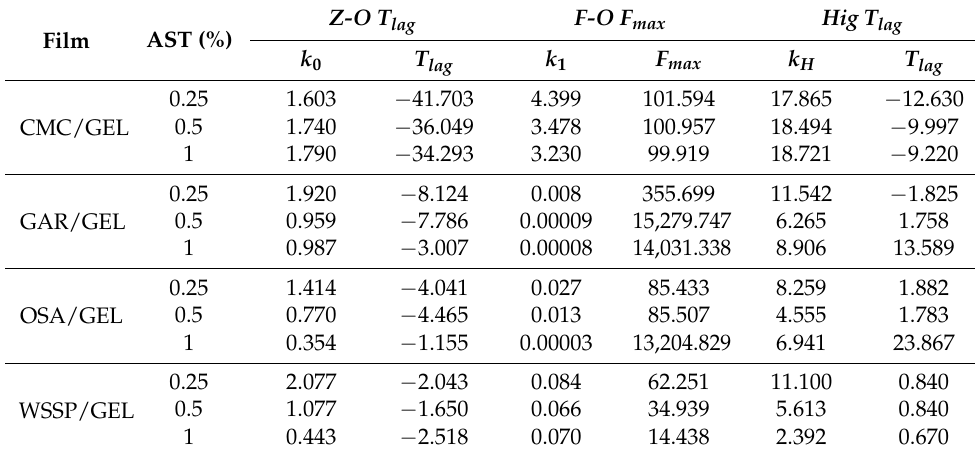
Table 4. Kinetic parameters obtained from two-parameter modeling.